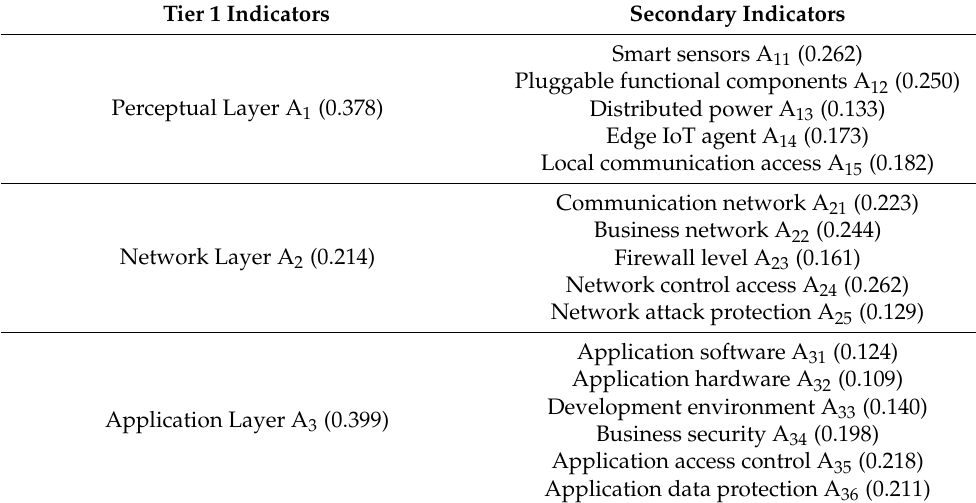
Table 2. Weight of PDIoT three-level security evaluation index calculated according to the entropy- weight